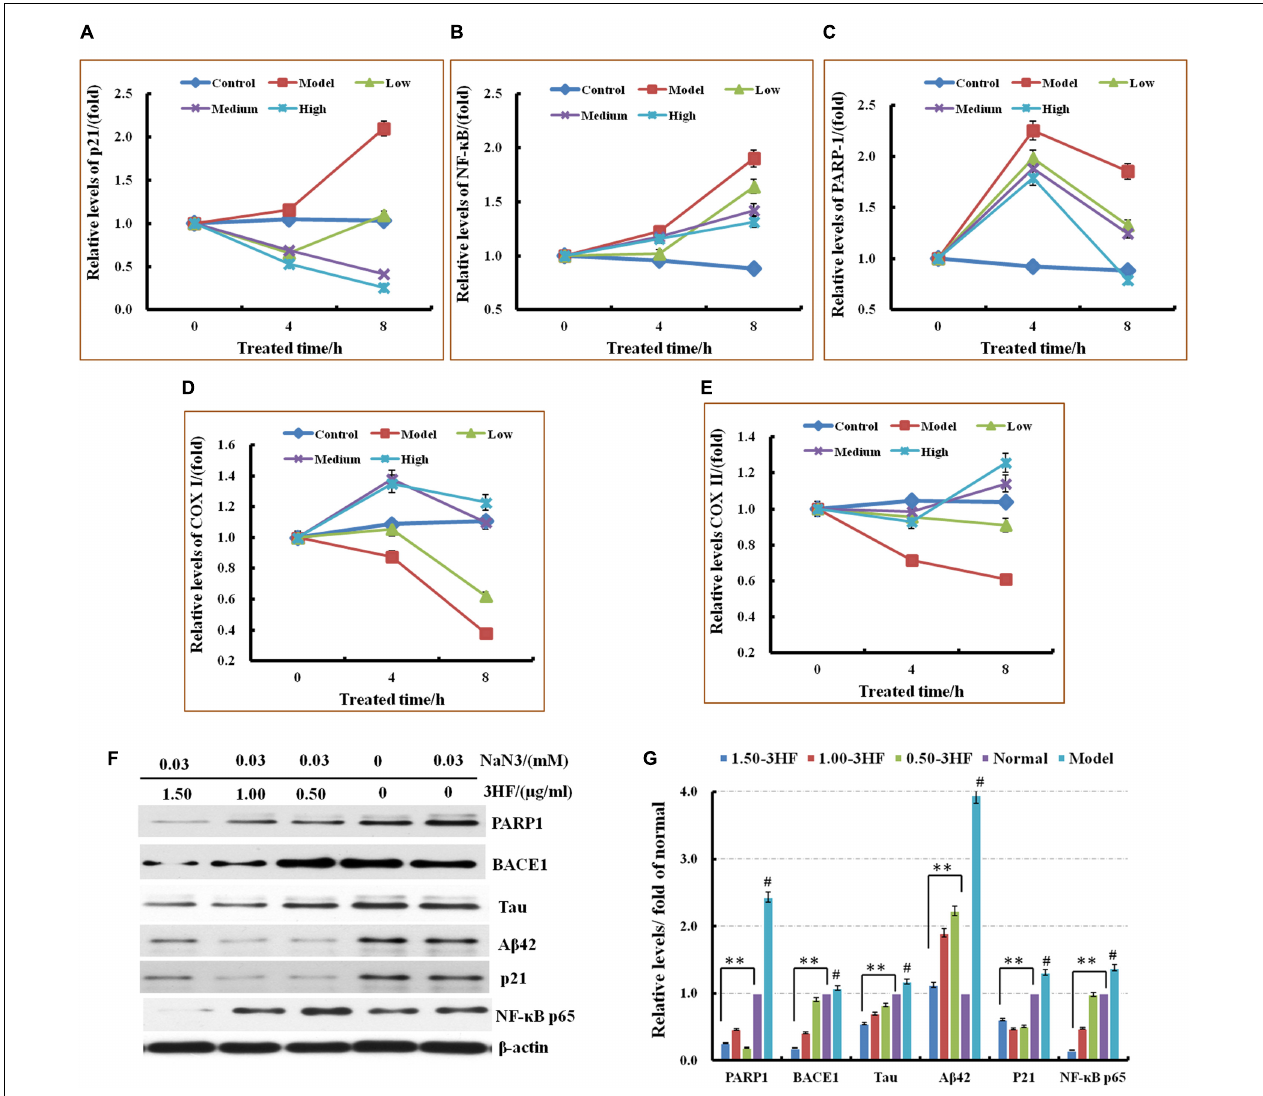
FIGURE 4 | Effects of 3HF on the mRNA expression levels of PARP1, p21, NF- κ B p65, COX I, and COX II (A–E) and the expression of the proteins related to mitochondrial dysfunction. 3HF reduced BACE1 although it reduced p-Tau and A β 42 expression (F,G) . Cells were pretreated with 3HF at the concentrations of 0.05, 1.00, and 1.50 µ g/ml for 2 h, followed by exposure to 0.03 mM of NaN 3 for 12 h, and the protein extracts were used for Western blot analysis of the indicated proteins. The blots were probed with β -actin for the loading control validation # p < 0.01 compared with control group; ∗ p < 0.05 and ∗∗ p < 0.01 compared with the NaN 3 -treated